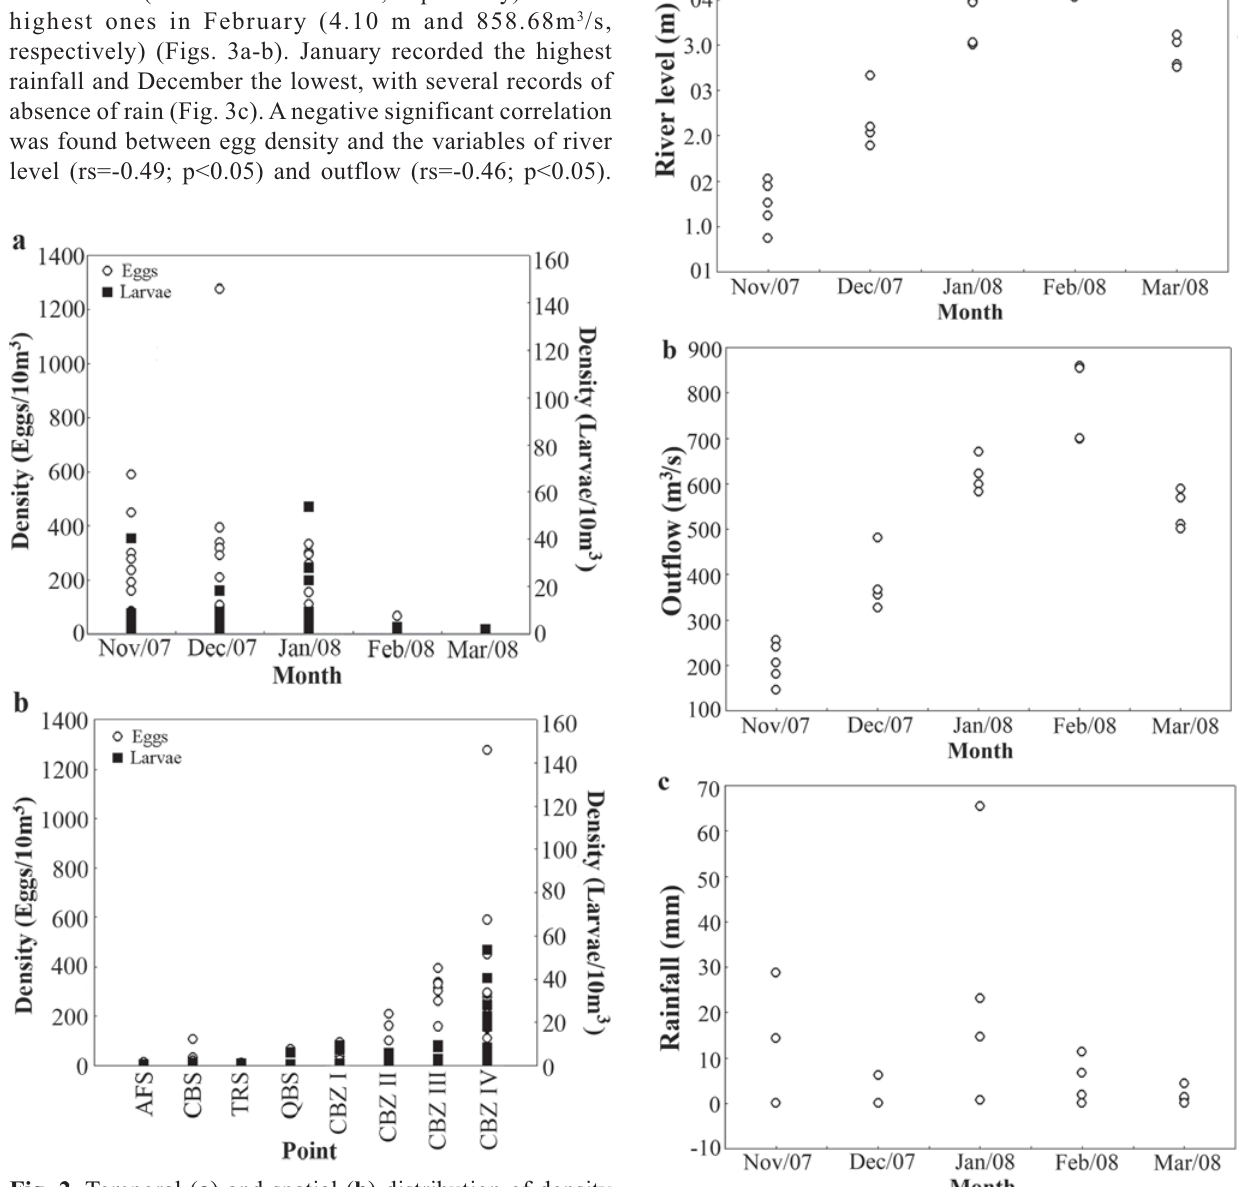
Fig. 2. Temporal ( a ) and spatial ( b ) distribution of density (individuals/10m 3 ) of fish eggs and larvae captured in the headwaters of the Cuiabá River, in all the collection sites, between November 2007 and March 2008.